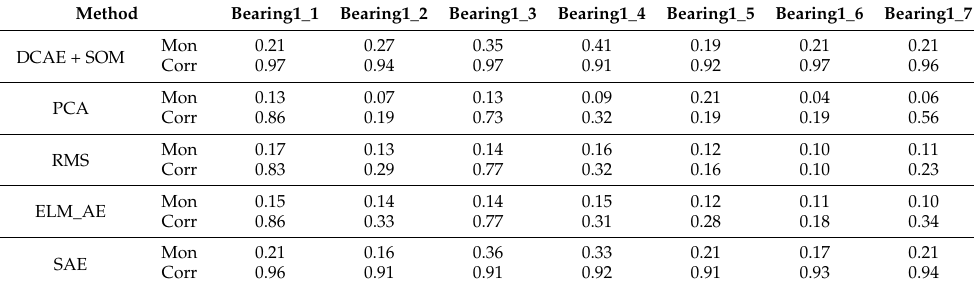
Table 2. HI curve evaluation results.